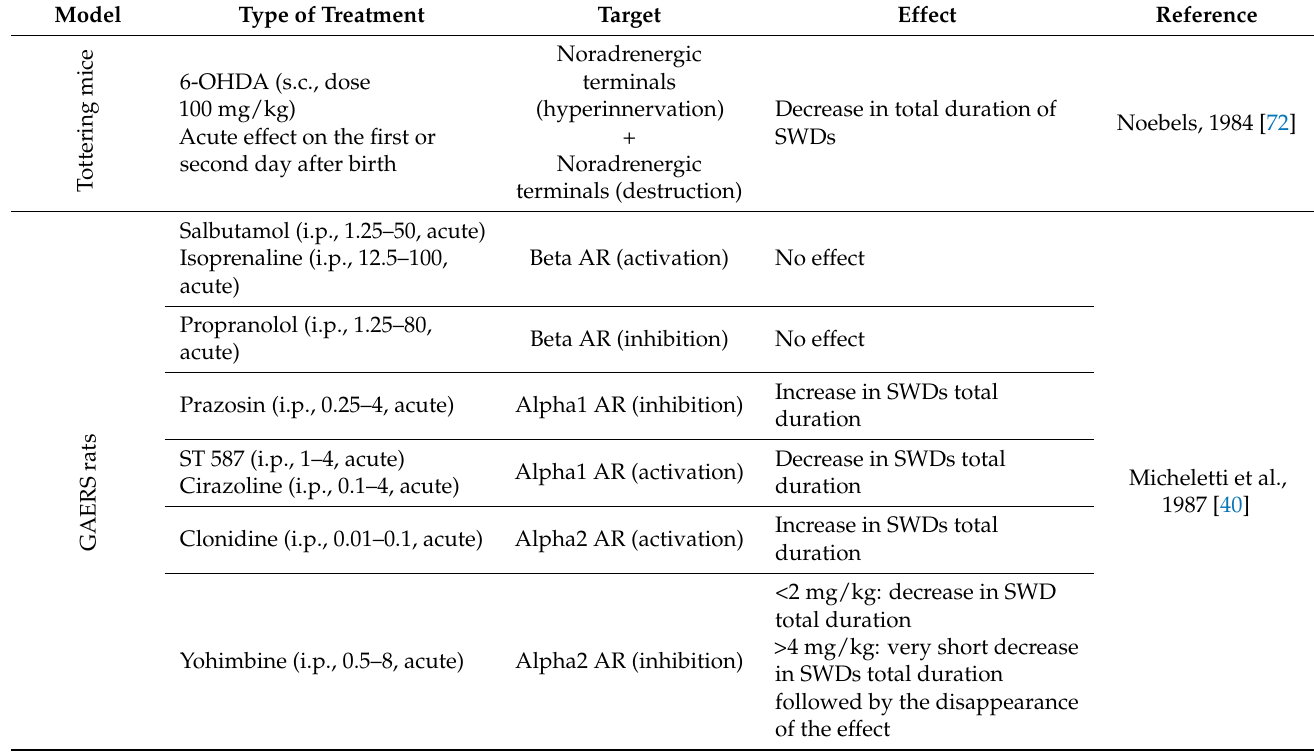
Table 2. Noradrenergic modulation of spike-wave discharges and similar